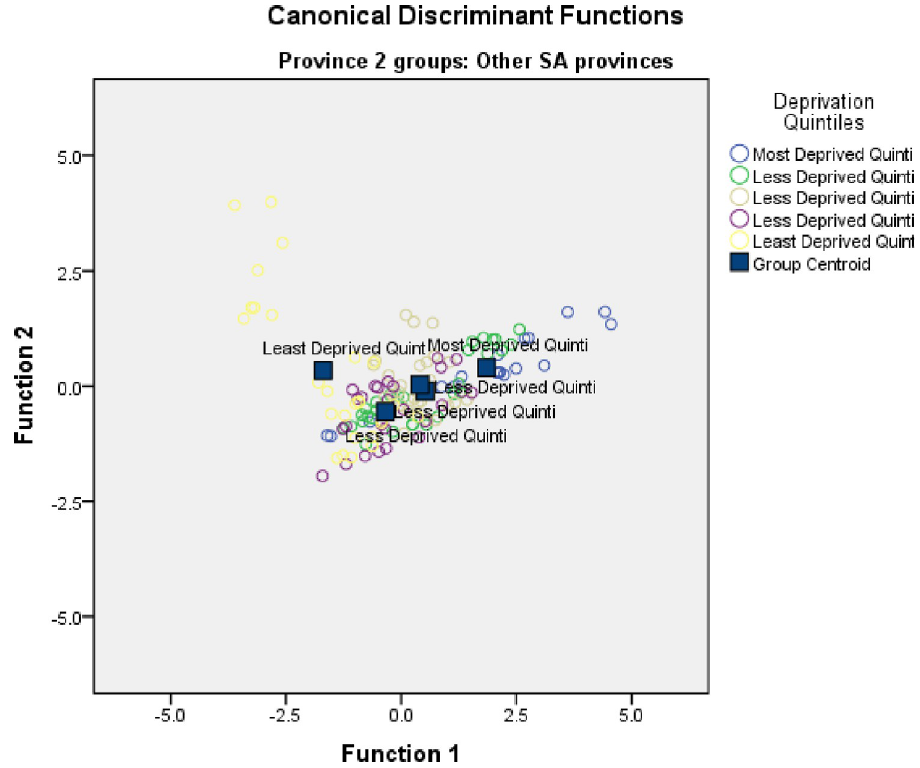
Fig 4. Canonical discriminant functions displaying socio-economic deprivation quintiles (Group centroids) discriminated by TB care outcomes between 2009–2013 in OR Tambo district.